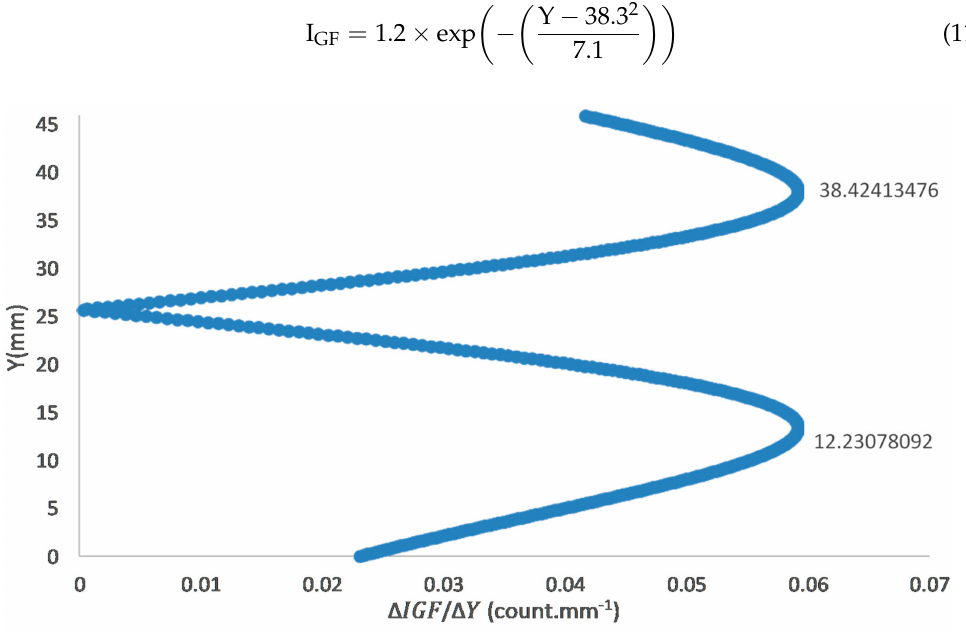
Figure 5. Absolute gradient of the Laser sheet Gaussian